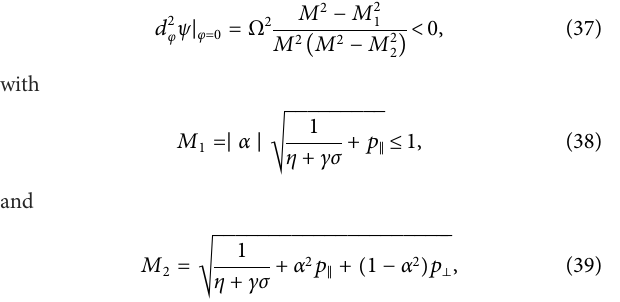
compressive (positive potential) solitary pulses. By keeping γ = 0 and neglecting p (cid:3) and p ⊥ we can retrieve the result of Ref. [29]. plotted M 1 and M 2 in Figure 2 for different values of p (cid:3) = 0.20 (solid curve), 0.30 (dashed curve) and 0.40 (dot-dashed curve).